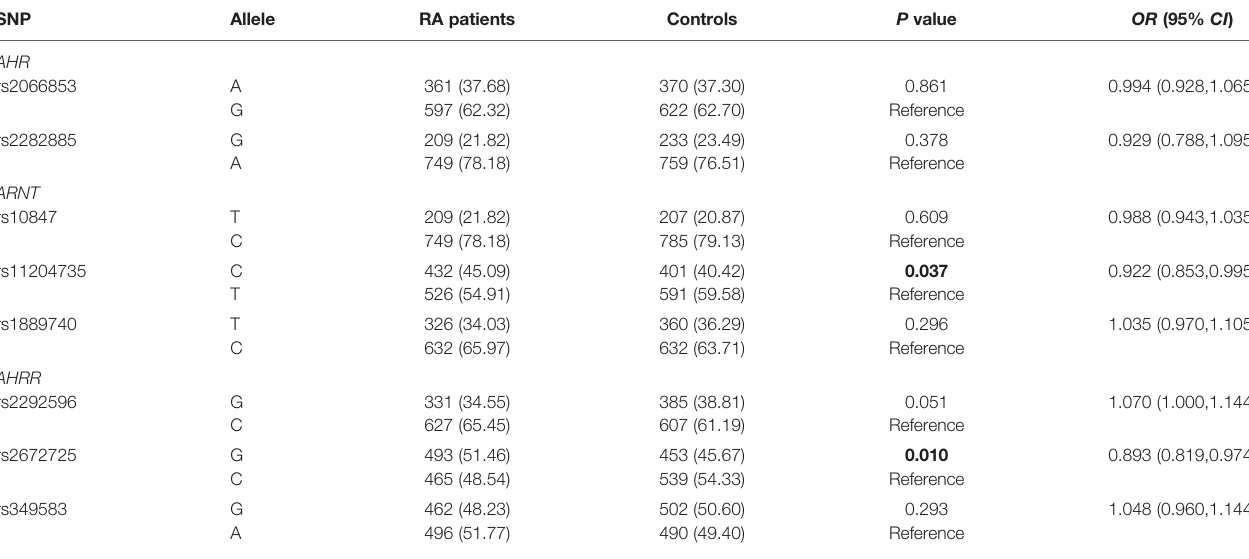
TABLE 3 | Allele frequencies of AHR, ARNT, AHRR genes in RA patients and controls. SNP Allele RA